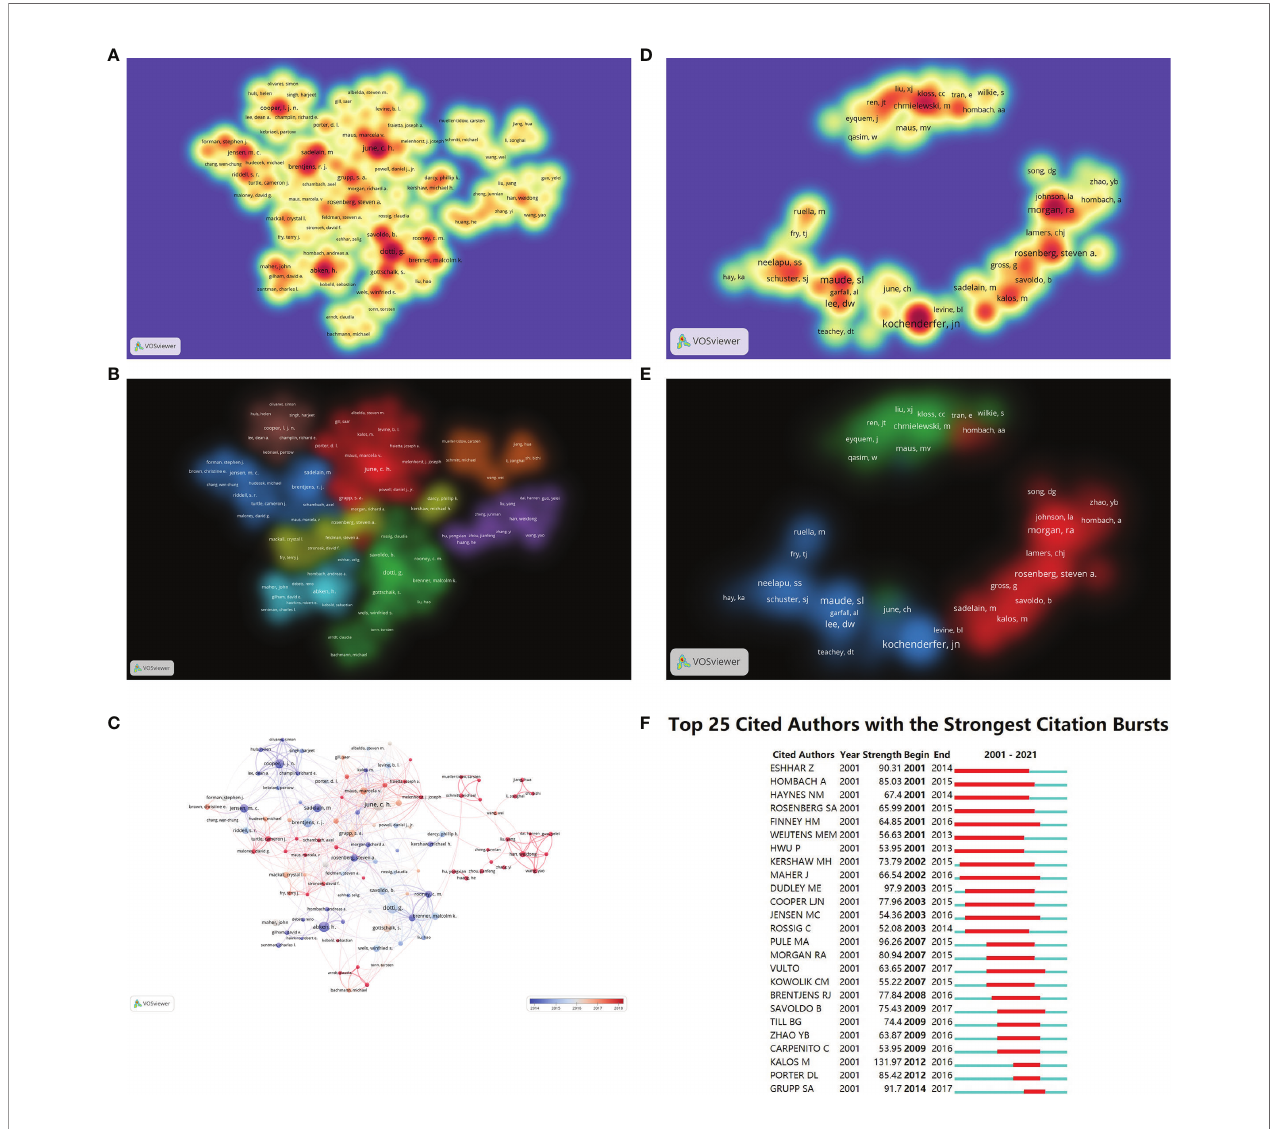
FIGURE 4 | Scholar cooperation maps. (A) The spectral density map of the top 100 most productive authors. (B) The cluster-overlay map of the top 100 most productive authors. (C) Time-overlay maps of the top 100 most productive authors. Each node represents an author, and each line represents the link between two authors. (D) The spectral density maps of the top 100 most co-cited authors. (E) The cluster-overlay map of the top 100 most co-cited authors. (F) The top 25 cited authors with the strongest citation